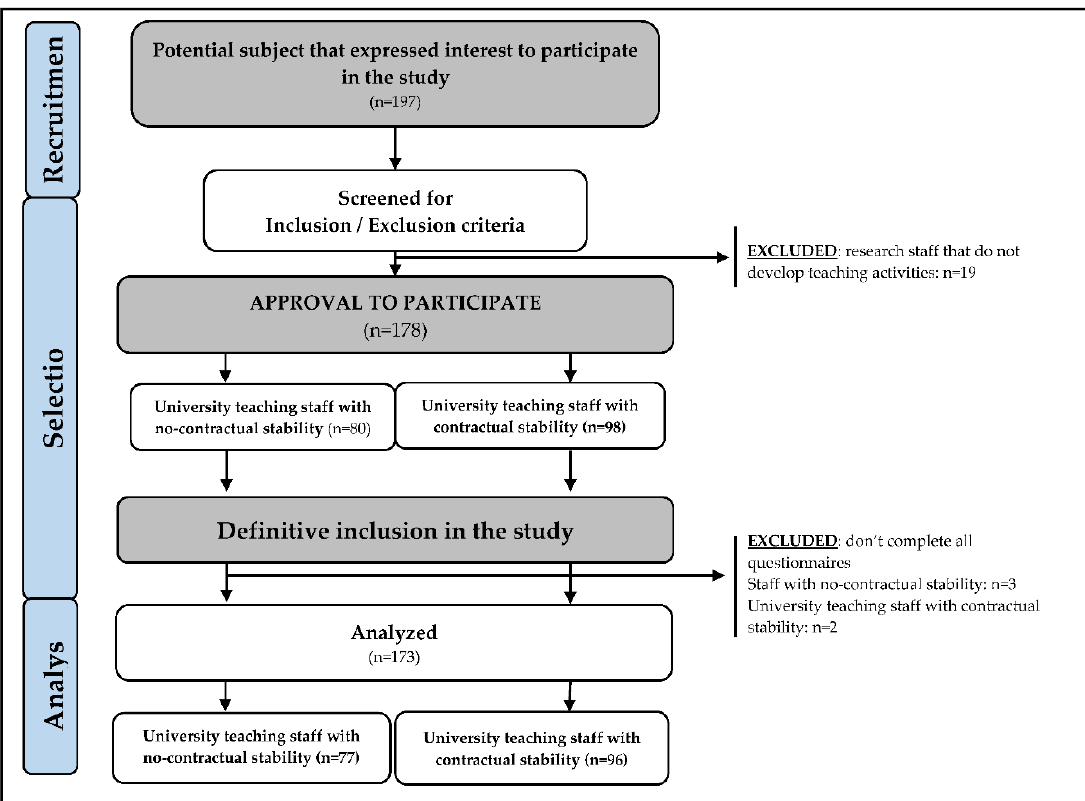
Figure 1. Flowchart of recruitment, selection, and analysis of participants.